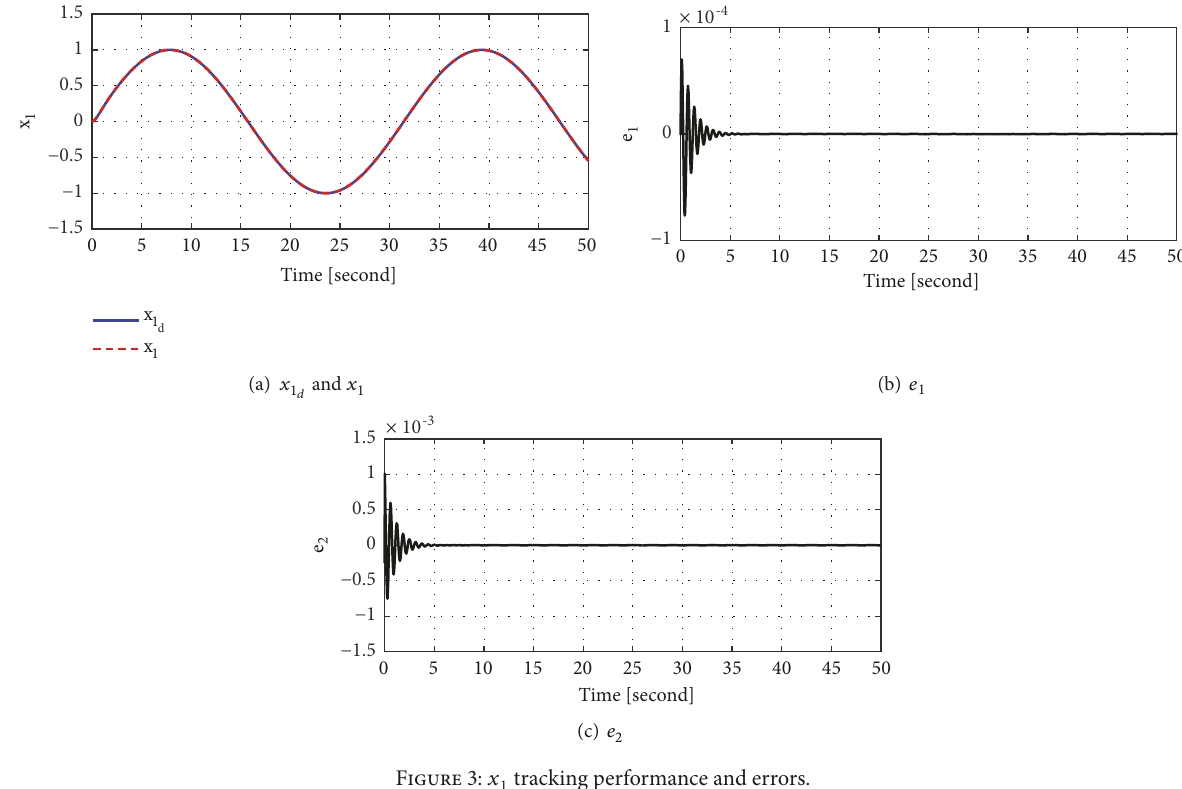
Figure 3: 𝑥 1 tracking performance and errors.